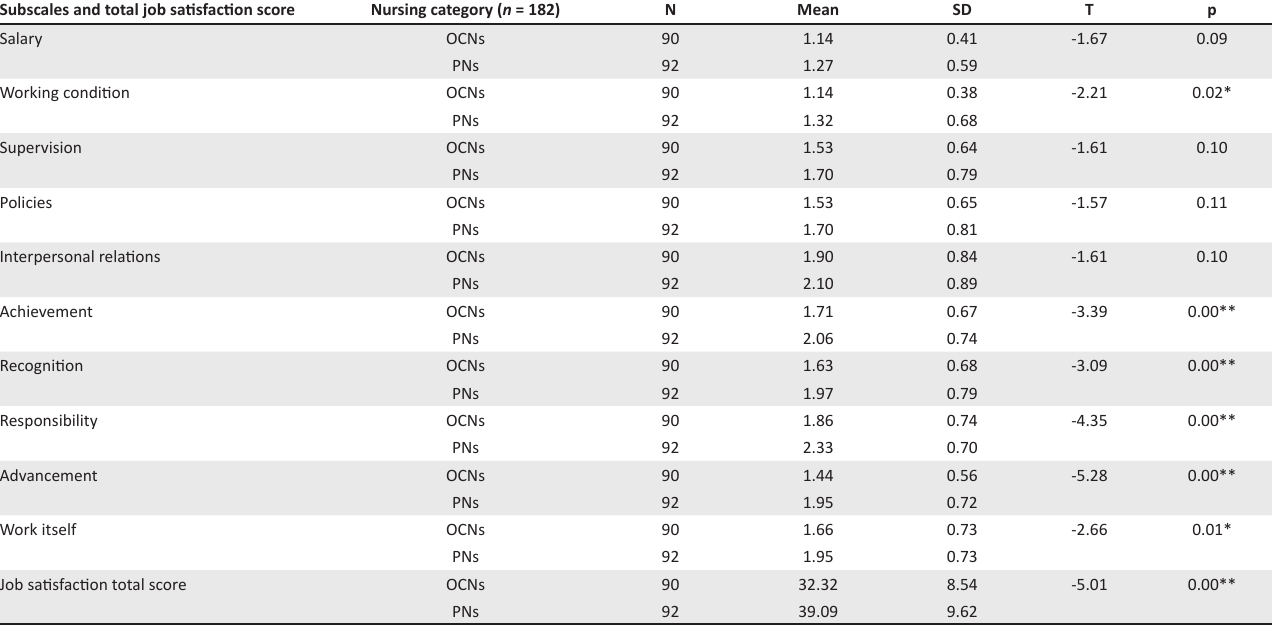
TABLE 4: The aggregate job satisfaction amongst PNs and OCNs based on the subscales and total job satisfaction scores using the t -test ( n = 182). Subscales and total job satisfaction score